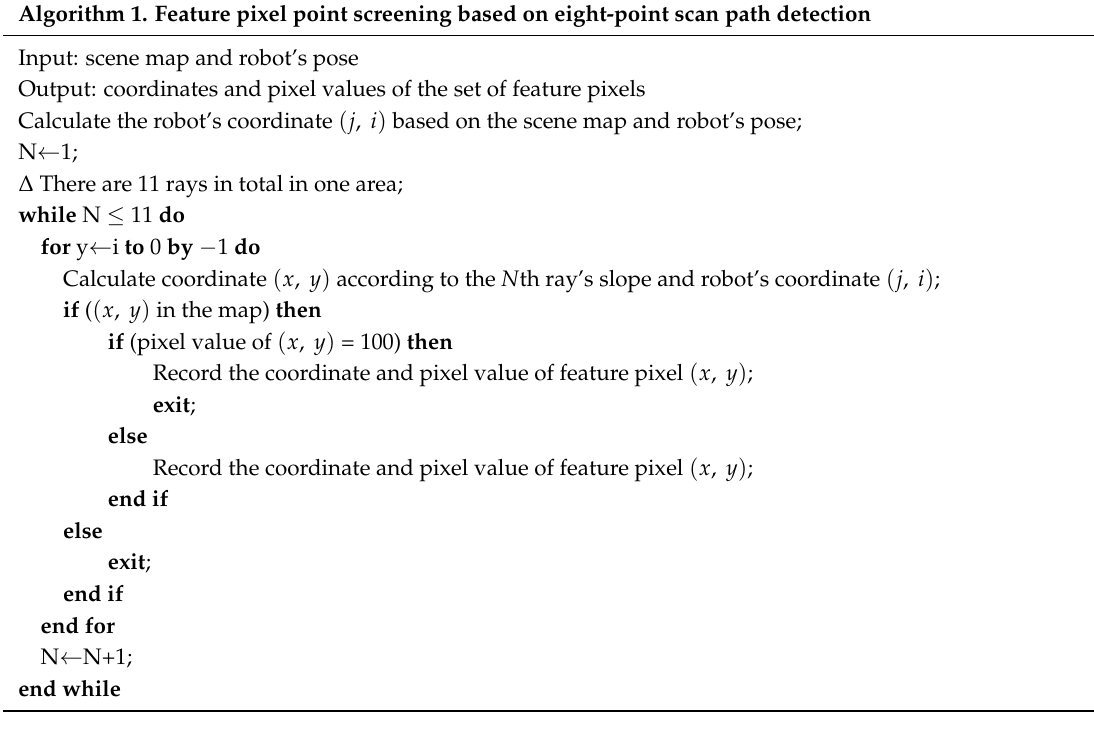
Algorithm 1. Feature pixel point screening based on eight-point scan path